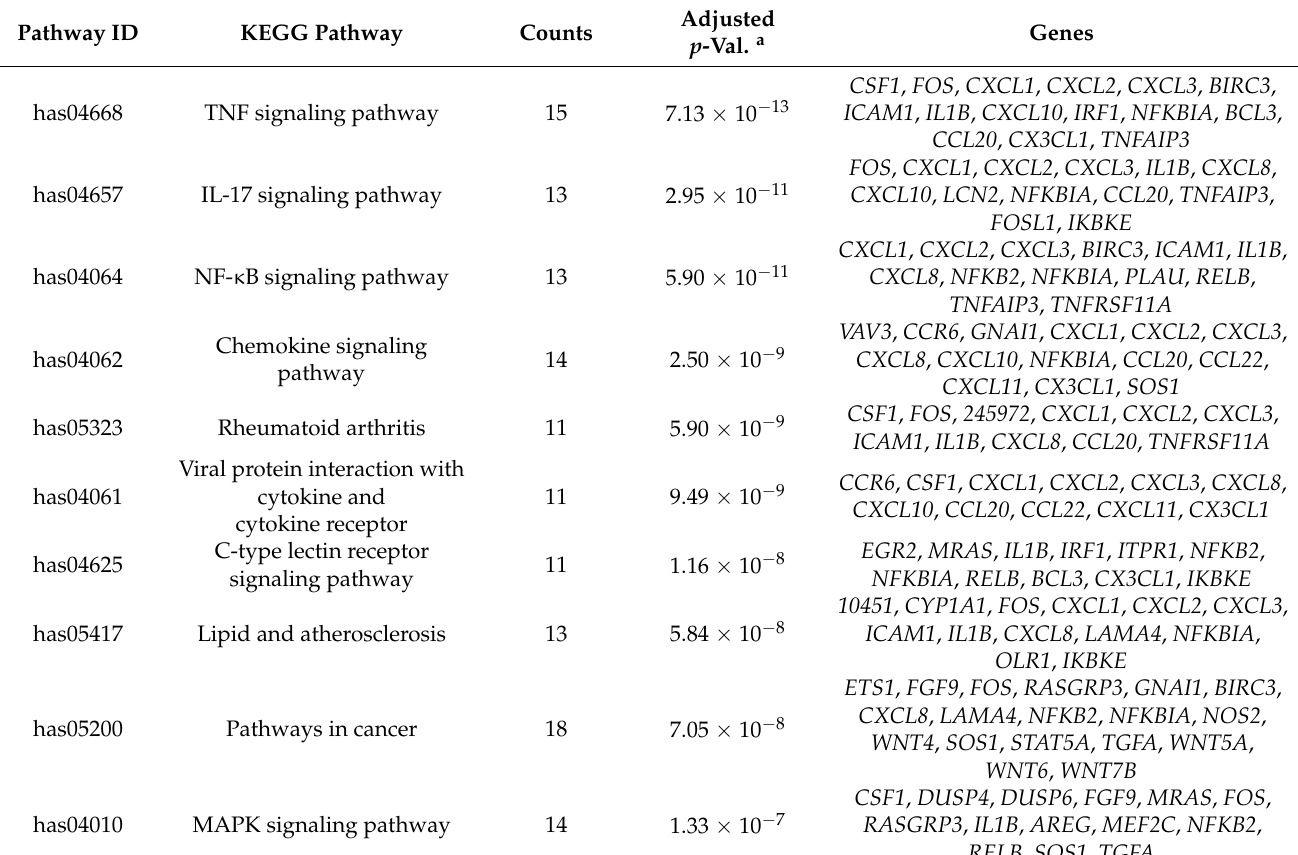
Table 2. Top 10 KEGG pathways enrichment analysis of differentially expressed genes in Caco-2 stimulated with CotG-p75.